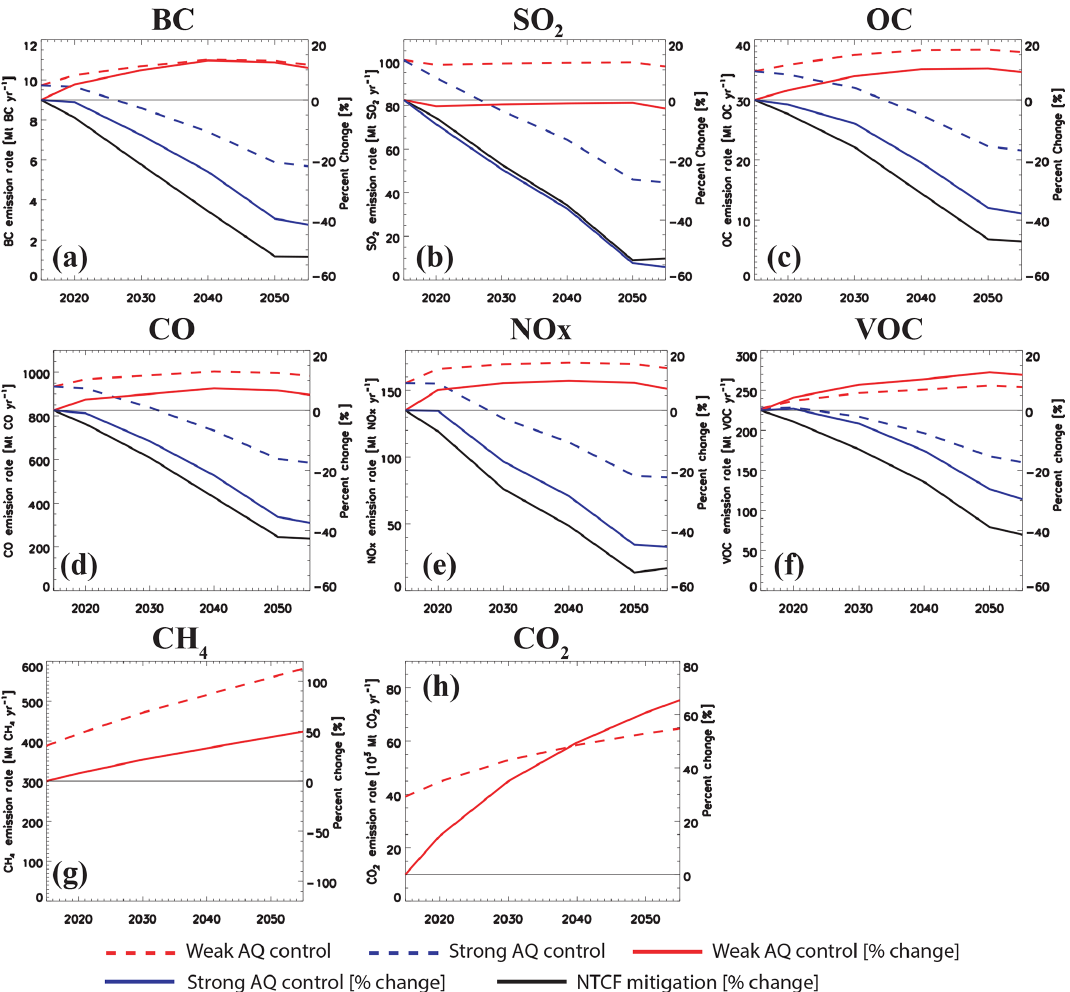
Figure 1. The 2015–2055 global mean CO 2 , NTCF, and precursor gas emissions. Panels show (a) black carbon (BC); (b) sulfur dioxide (SO 2 ); (c) organic carbon (OC); (d) carbon monoxide (CO); (e) nitrogen oxides (NO x ); (f) volatile organic compounds (VOC); (g) methane (CH 4 ); and (h) carbon dioxide (CO 2 ) emissions for weak (red) and strong (blue) air quality control. Also included is the percent change (relative to 2015) for weak (red solid) and strong (blue solid) air quality control, and NTCF mitigation (black solid). Emission units for species X are Mt X yr − 1 . Percent change units are %. Only weak air quality control CO 2 and CH 4 emissions are shown, as AerChemMIP simulations include the same change in CO 2 and CH 4 emissions based on the weak air quality control scenario. Emissions data come directly from the CMIP6 forcing datasets, which were downloaded from the input datasets for Model Intercomparison Project